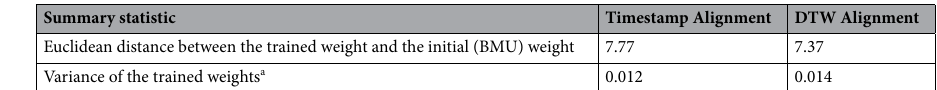
Table 2. Quantitative comparison of the trained weights resulting from one iteration of the timestamp training rule vs. the DTW training rule on a randomly selected observation from the 24-h outdoor temperature time series. a Variance of the input time series was 0.017 and the variance of the initial BMU weights was 0.010.